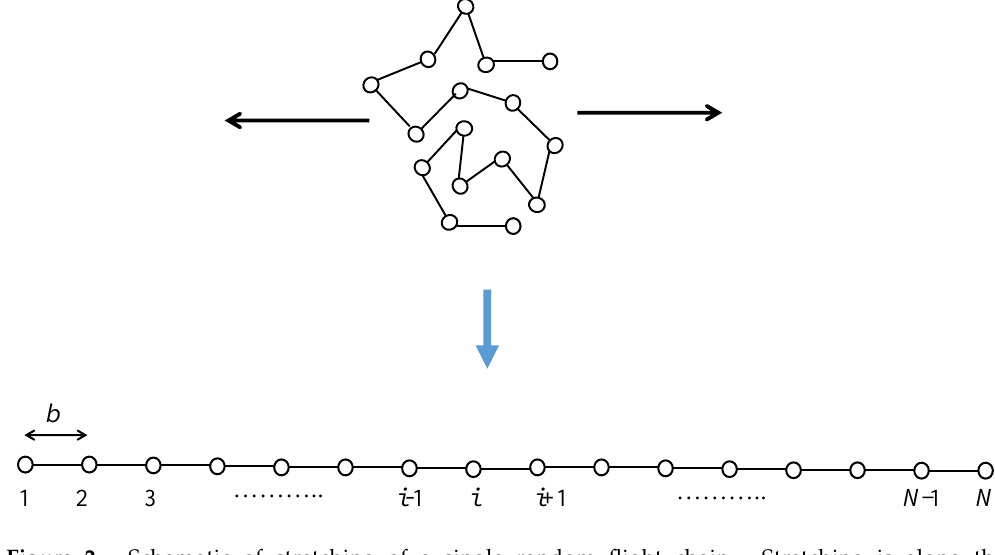
Figure 2. Schematic of stretching of a single random flight chain. Stretching is along the horizontal